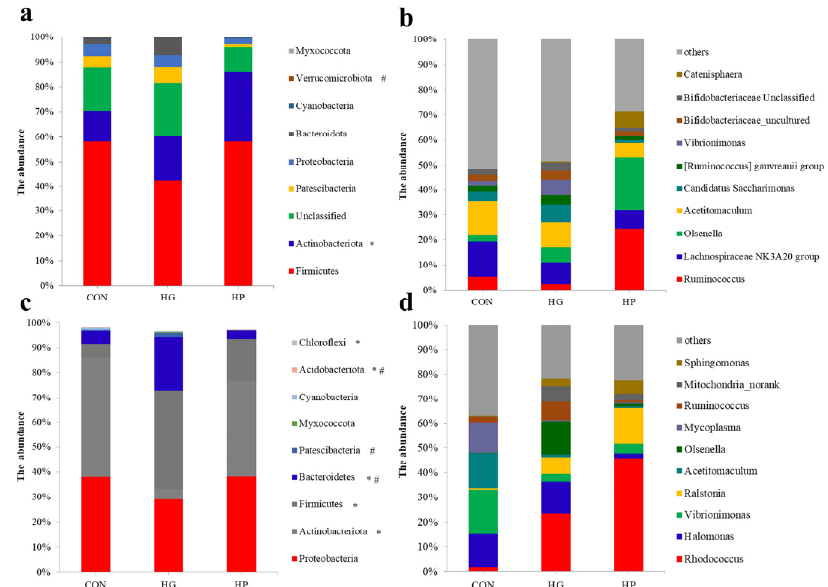
Figure 1. Taxonomic analysis of jejunal digesta- and mucosa-associated microbiota in Hu sheep (n = 5) fed CON, HG and HP diets at different taxonomic levels. The composition of the digesta-associated microbiota at the phylum ( a ) and genus ( b ) levels. The composition of the mucosa-associated microbiota at the phylum ( c ) and genus ( d ) levels. * indicates that there has a significant difference between the CON and HG groups; # indicates that there has a significant difference between the HG and HP groups. CON, the control group; HG, the high-grain group; HP, the pelleted high-grain